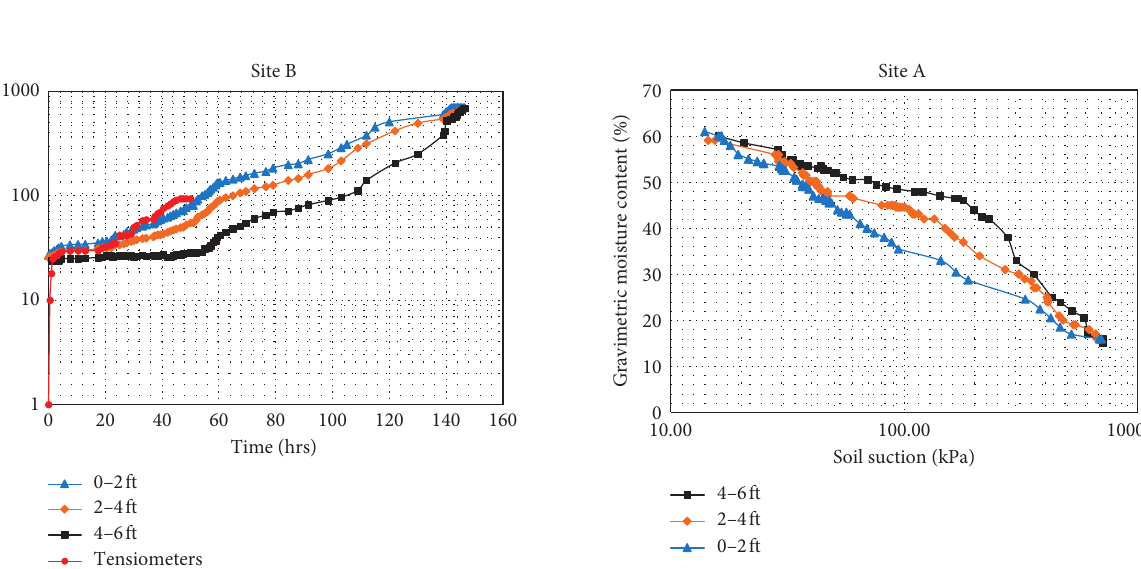
Figure 13: Typical soil-water characteristic curves for site A.